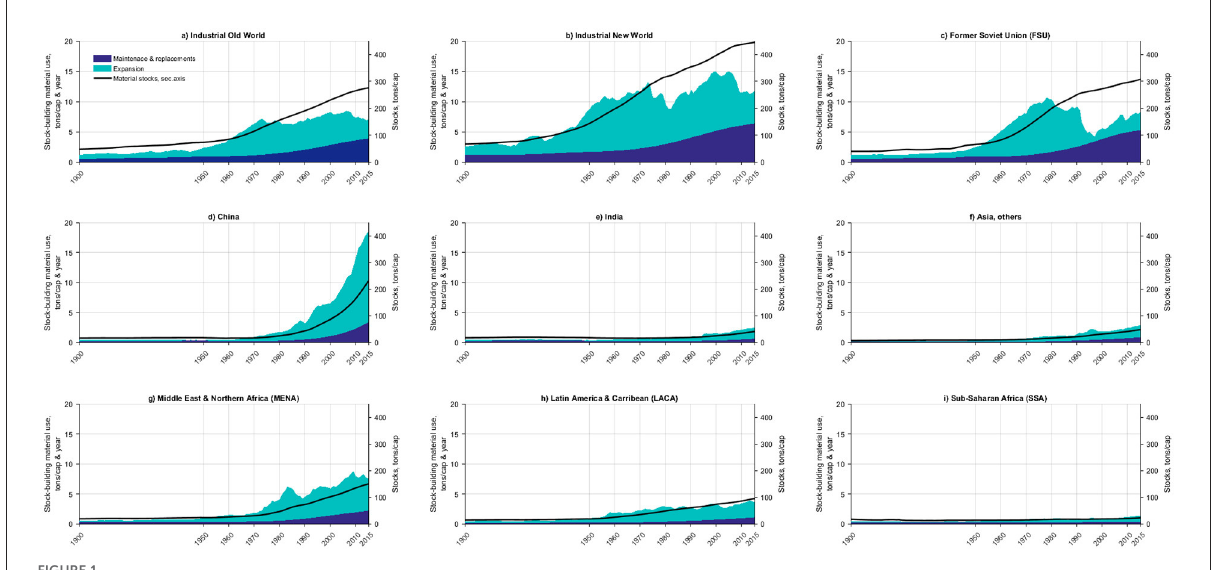
FIGURE1 Material stocks in nine world regions and their expansion versus maintenance and replacement flows in the period 1900–2015. Source: (Wiedenhofer et al., 2021). Courtesy of Dr. Dominik Wiedenhofer, Institute of Social Ecology Vienna (SEC), Department of Economics and Social Sciences (WiSo), University of Natural Resources and Life Sciences, Vienna